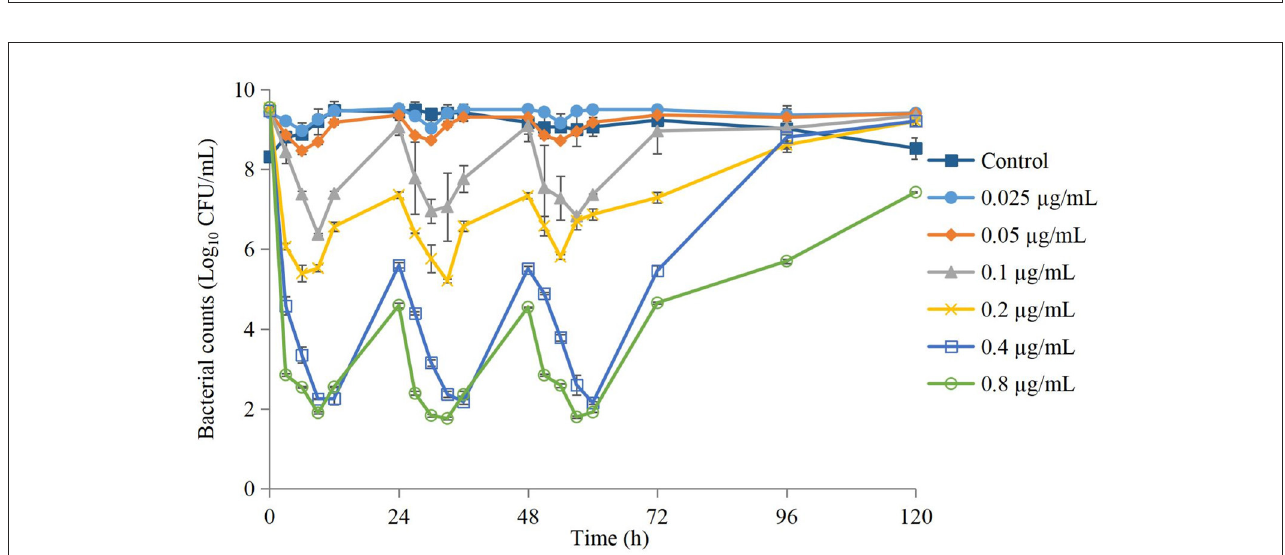
FIGURE2 Time-kill curves of danofloxacin against Actinobacillus pleuropneumoniae after administration of different dosages. Values are the mean ± standard deviation ( n = 3).